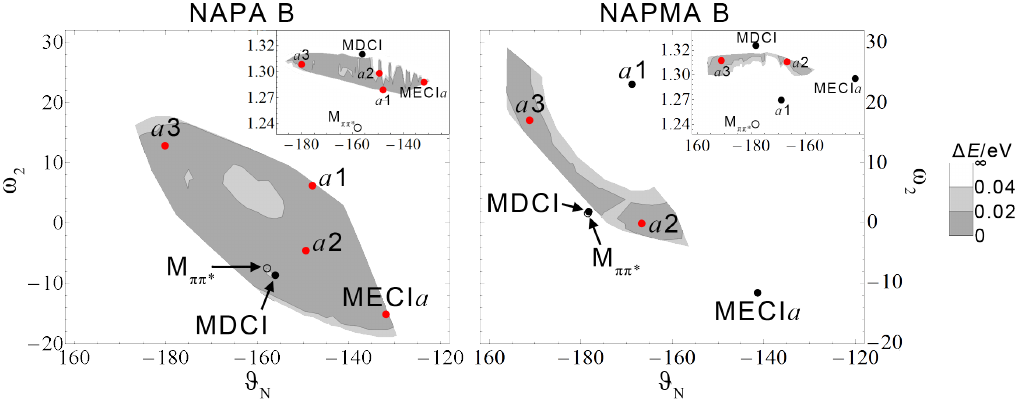
Figure 9. Two-dimensional projections of the classically-accessible portion of the ππ ∗ / n π ∗ the basin a of NAPA (left) and NAPMA (right). Projections on the ϑ N and ω 2 angles are show in the main panel. Insets show the same portion of the seam projected on the subspace spanned by d ( C Phe = O ) (vertical axis, in Å) and ϑ N (horizontal axis, in degrees). In total, 153 NAPA and 63 NAPMA CI geometries have been used. The reference zero point energy (ZPE) accessible (inaccessible) LIP/MECI structures are shown with red (black) dots. Open circles indicate M ππ ∗ . Shades of gray indicate the size of the energy gap (eV) between the two adiabatic